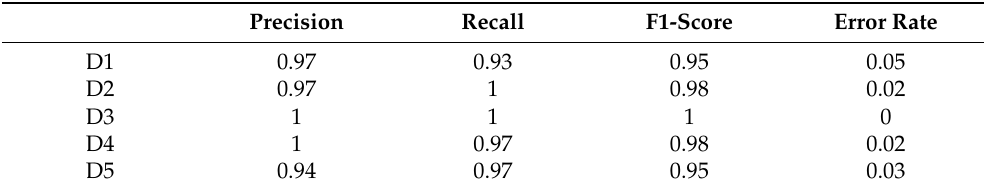
Table 5. The common evaluation metrics results of PSO-SVM.